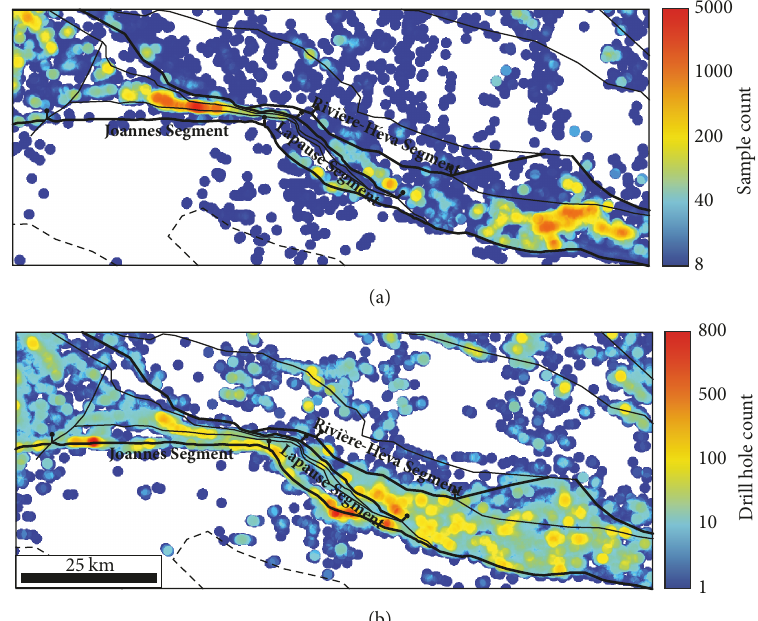
Figure 7: Distribution of exploration efforts surrounding the CLLF. (a) Grab samples. (b) Drill holes. Interpolations use a search radius of